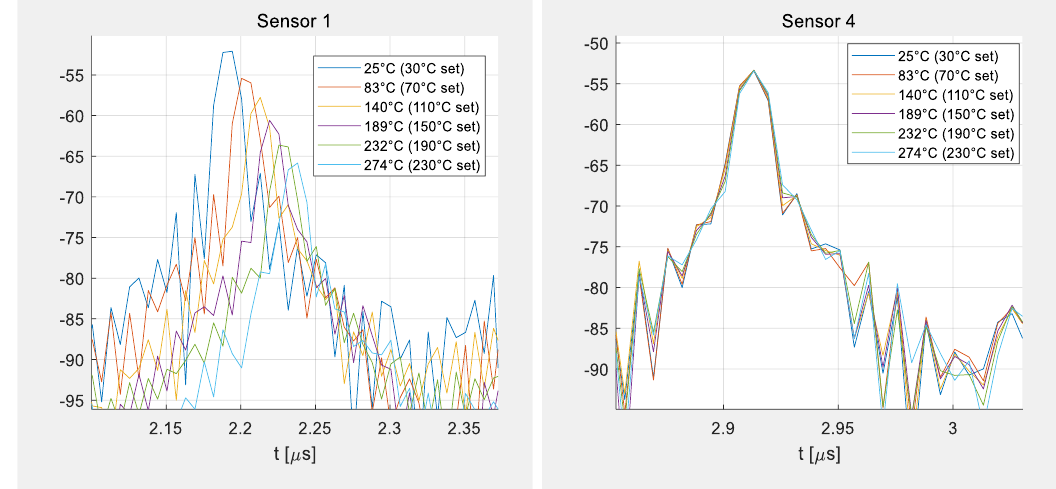
Figure 6. Details of Figure 5 showing the shift of the last peaks of sensor 1 (left) and sensor 4 (right)